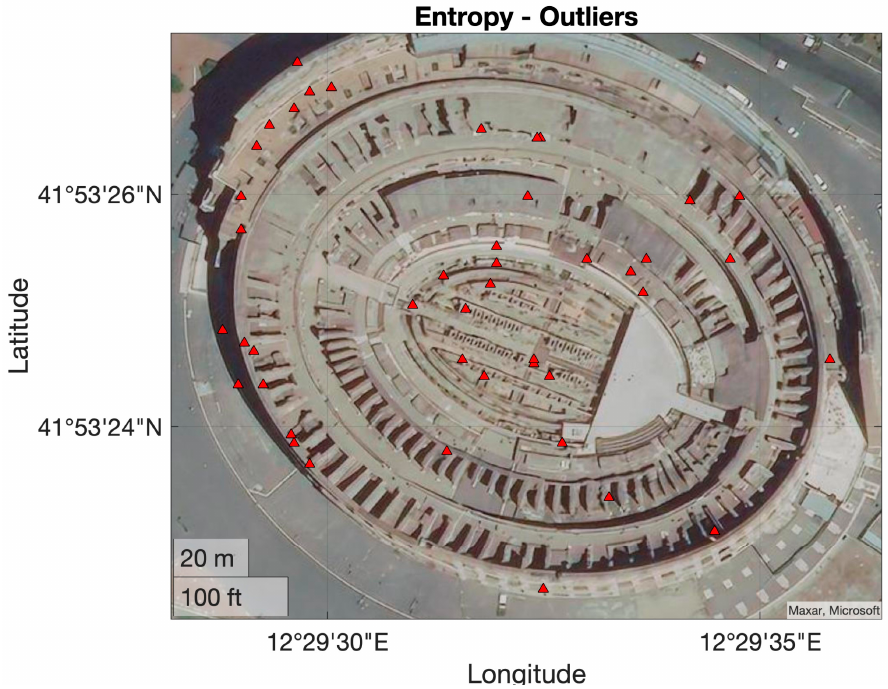
Figure 18. Map showing the outliers evaluated from the entropy–energy PDF for the Colosseum.